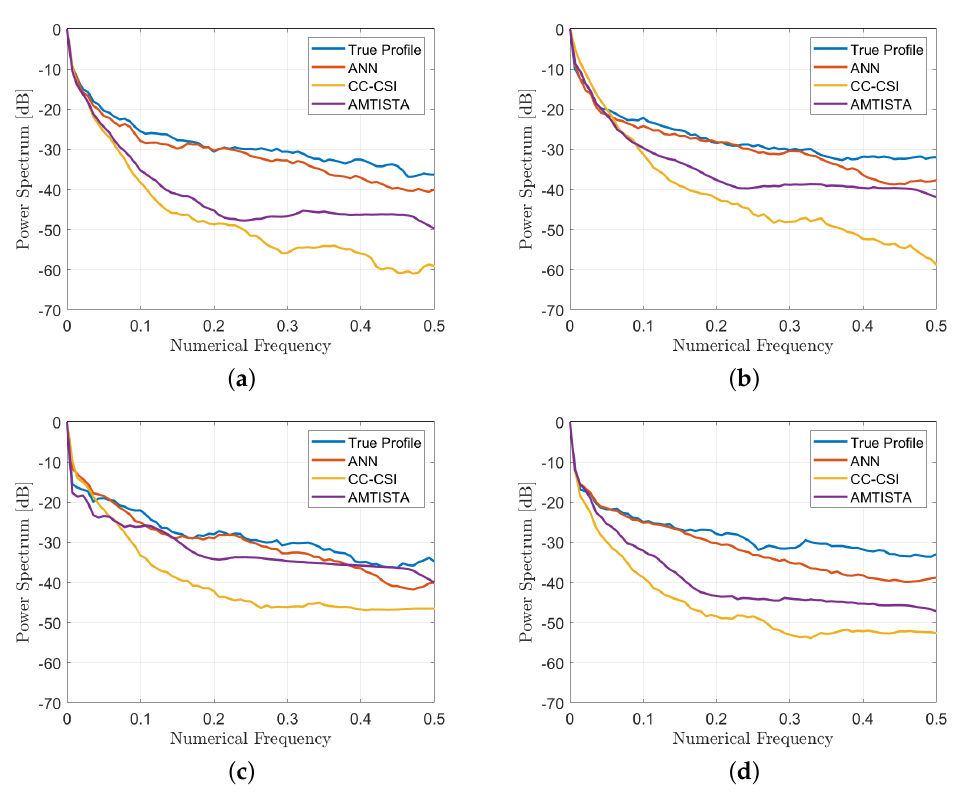
Figure 8. One-dimensional power spectrum indicator of Equation (4) for the retrieved profiles reported in Figures 6 and 7.